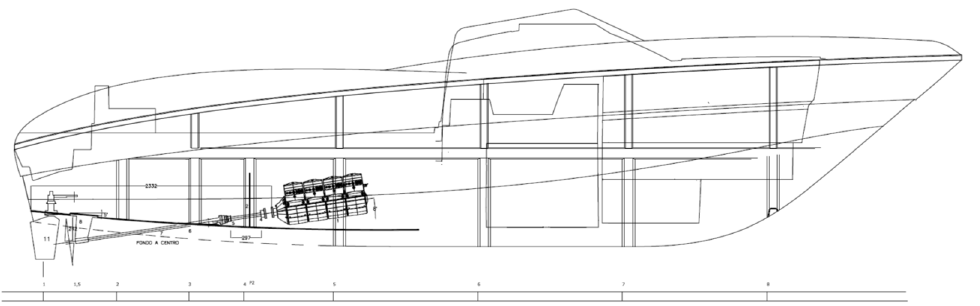
Figure 12. Electric engine and propeller shaft installation.